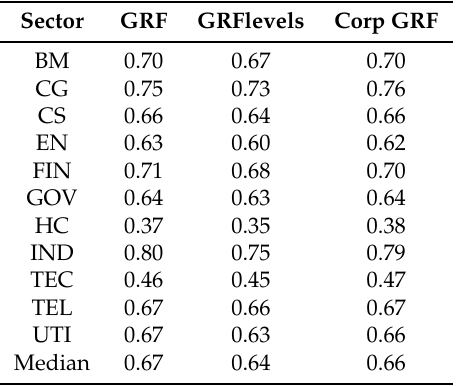
Table 16. Explanatory power of alternative GRF estimates.